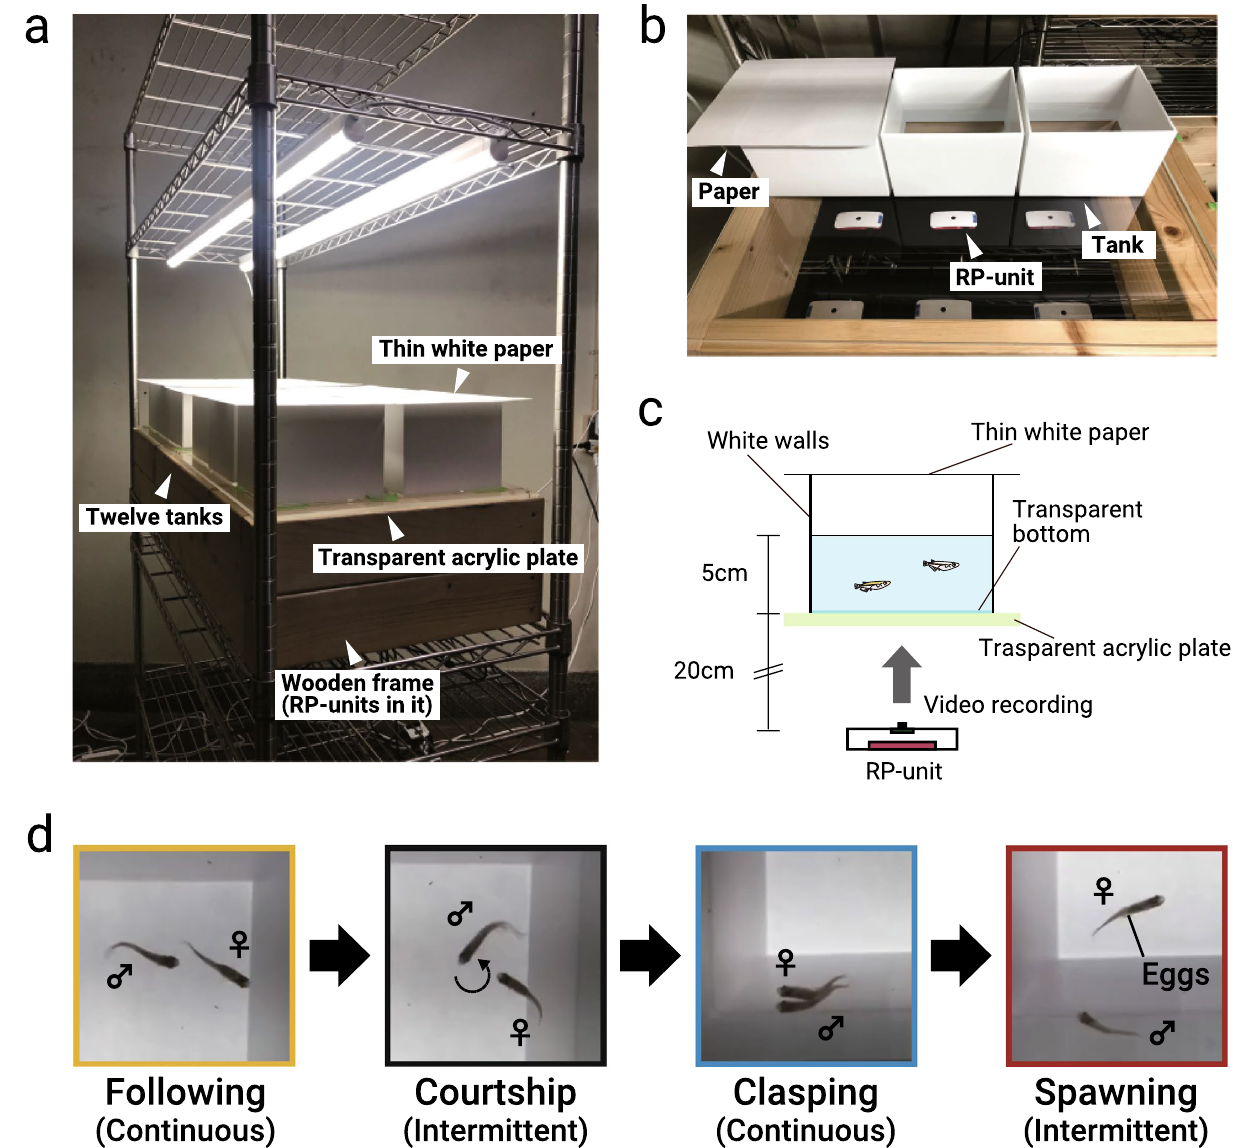
Figure 4. Experimental design for sexual behavior analysis. ( a ) Photograph of the whole experimental equipment for recording the sexual behavior of medaka. Wooden frame that was attached transparent acrylic plate was placed onto the 100 × 45 cm stainless rack. Twelve tanks, with their upper side covered by thin white paper, were put on the acrylic plate, and RP-units were placed inside the wooden frame. ( b ) Photograph of a part of experimental equipment taken from diagonally above. When performing experiments, thin white papers were put onto each tank, like the left tank of this figure. RP-units were placed directly below each tank. ( c ) Schematic illustrating of the experimental equipment. Since both the bottom of the tank and acrylic plate were transparent, it is possible for RP-units to record the videos from ventral side of the medaka. ( d) Schematic diagram of the sexual behavior sequence of medaka. Images of each of four behavioral repertoires were captured from the video data of one pair of d-rR. Colored frames and words in parentheses are corresponding with the setting of the Ethogramer